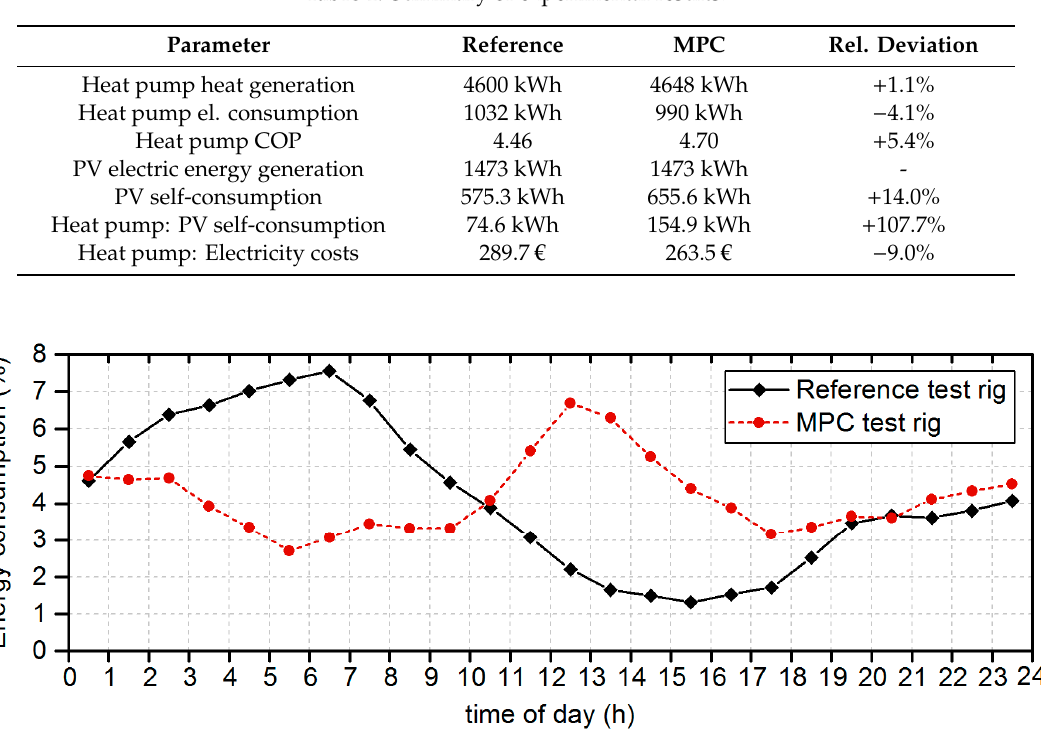
Table 1. Summary of experimental results.